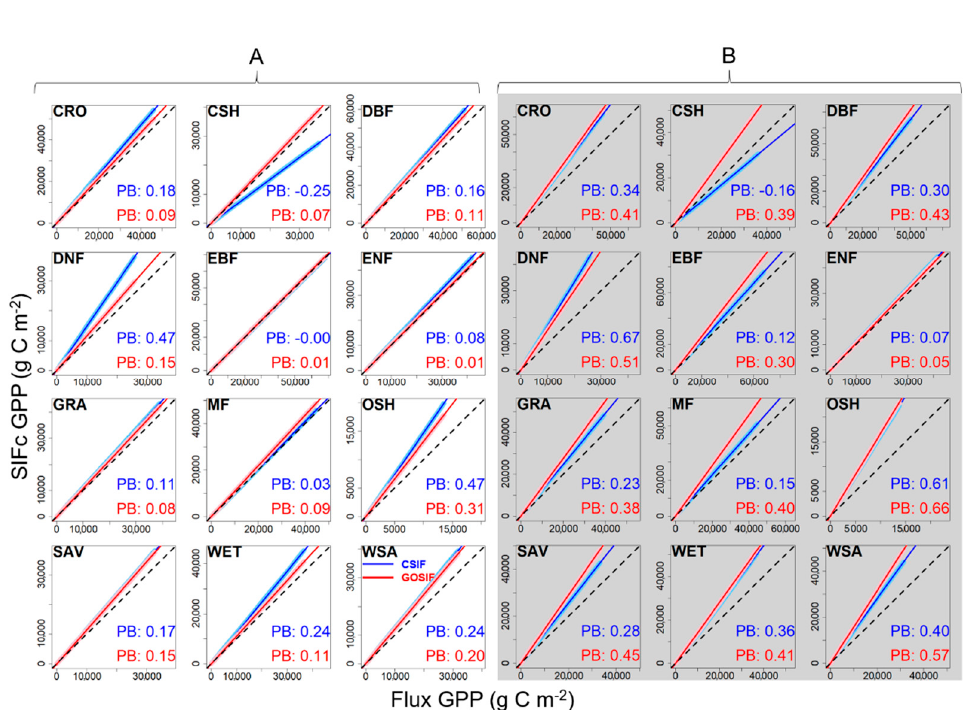
Figure 9. Comparison of the cumulative Flux_GPP and SIFc_GPP across 12 biomes. Median-based two-slope scheme ( A ) and mean-based two-slope scheme ( B ). The two two-slope schemes are listed in Table 1. The dash line is the 1:1 line. Blue and red lines are the fitted linear regression lines of cumulative CSIF_GPP and GOSIF_GPP with Flux_GPP, respectively, and their associated PB values are provided as well. To avoid the impacts of large unbalance in the number of GPP values across biomes on accumulative GPP, 10,000 daily Flux_GPP and SIFc_GPP value pairs were sampled with replacement for each biome for this comparison.